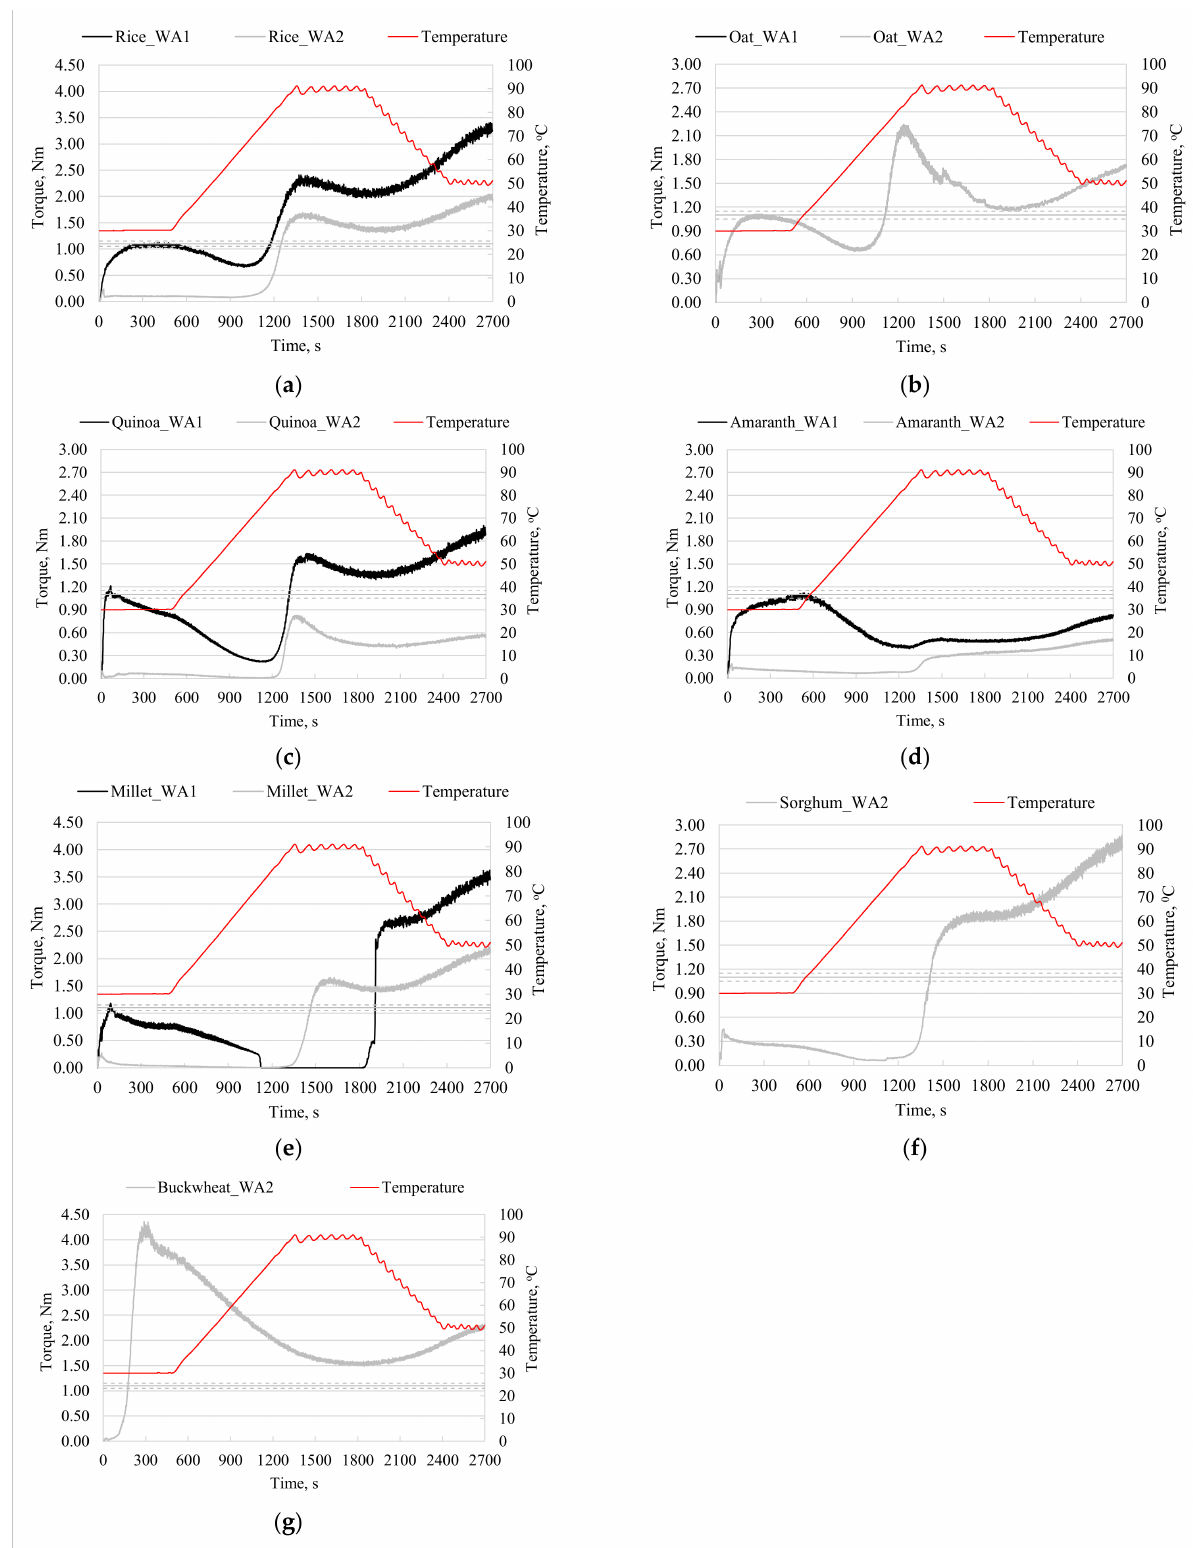
Figure 1. Mixolab curves of the dough samples prepared with rice ( a ), oat ( b ), quinoa ( c ), amaranth ( d ), millet ( e ), sorghum ( f ), and buckwheat ( g ) flour at different water absorption (WA) levels: WA1 necessary to obtain a maximum torque of 1.1 ± 0.05 Nm and WA2 of 85%. Note: For the oat flour, WA1 and WA2 had the same value of